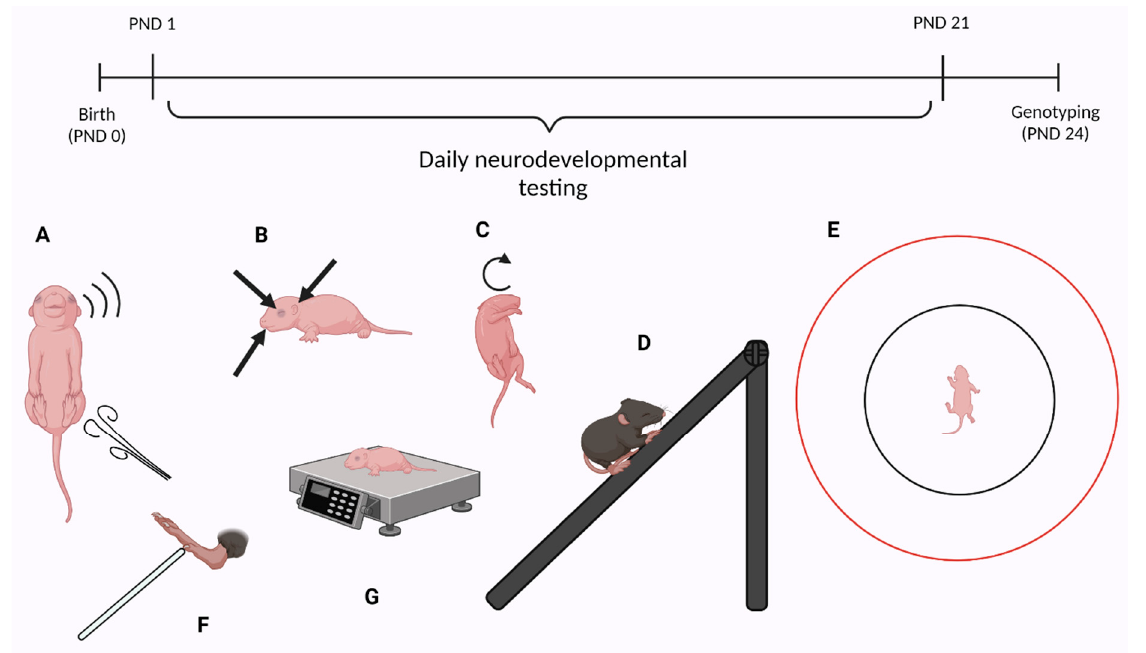
Figure 1. Timeline of the study including schematic for each measurement carried out daily. ( A ) Auditory and tactile startle. ( B ) Ear twitch reflex, ear unfolding, eye opening, upper/lower incisor eruption. ( C ) Surface and air righting. ( D ) Negative geotaxis. ( E ) Gait, walking initiation. ( F ) Forelimb grasp. ( G ) Body weight. Created with BioRender.com (accessed on 13 May 2022).